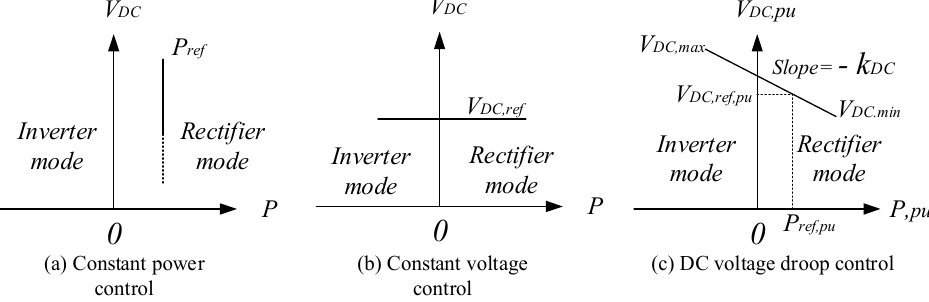
Figure 15. Characteristics of the three modes for outer controller: ( a ) constant power control; ( b ) constant voltage control; and ( c ) DC voltage droop control. ( b ) constant voltage control; and ( c ) DC voltage droop